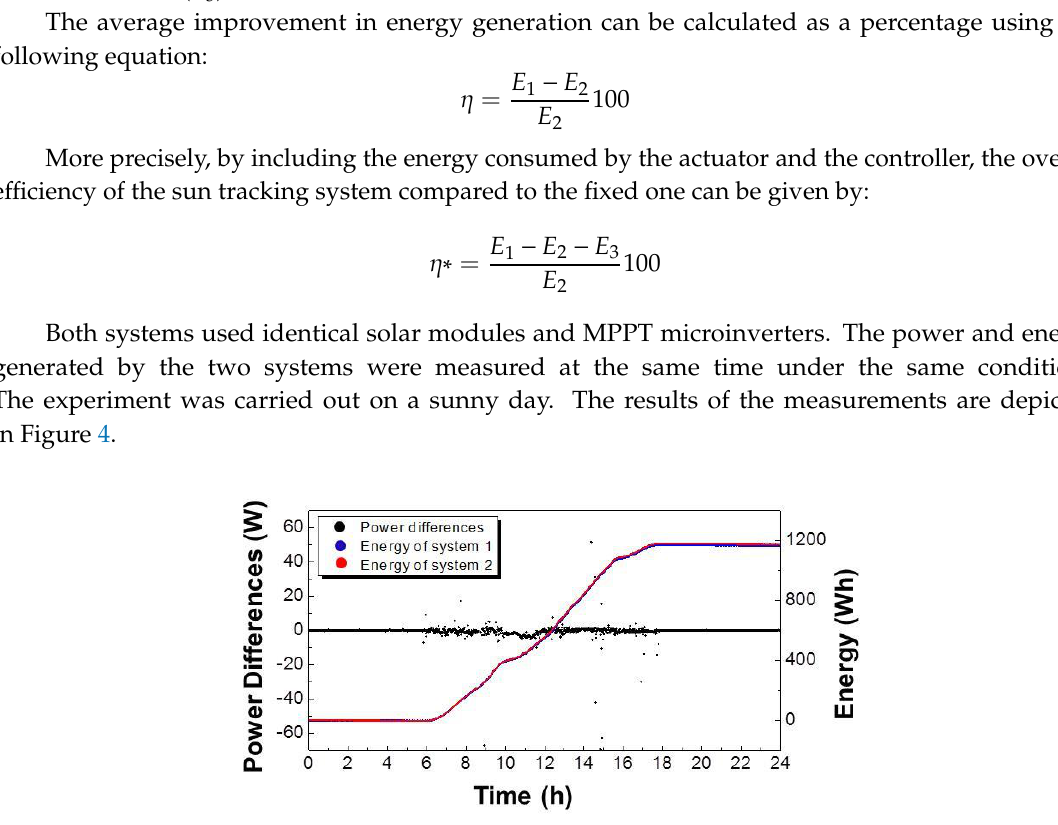
Figure 4. Di ff erences in power and energy generated by the two systems under the same Figure 4. Differences in power and energy generated by the two systems under the same conditions.